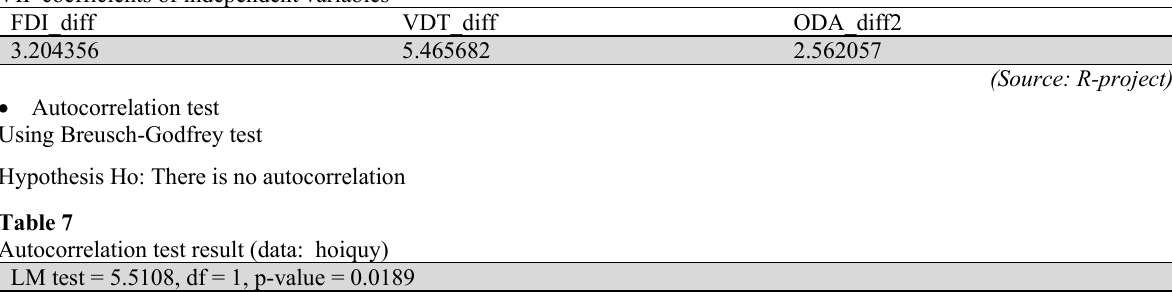
Autocorrelation test result (data: hoiquy)